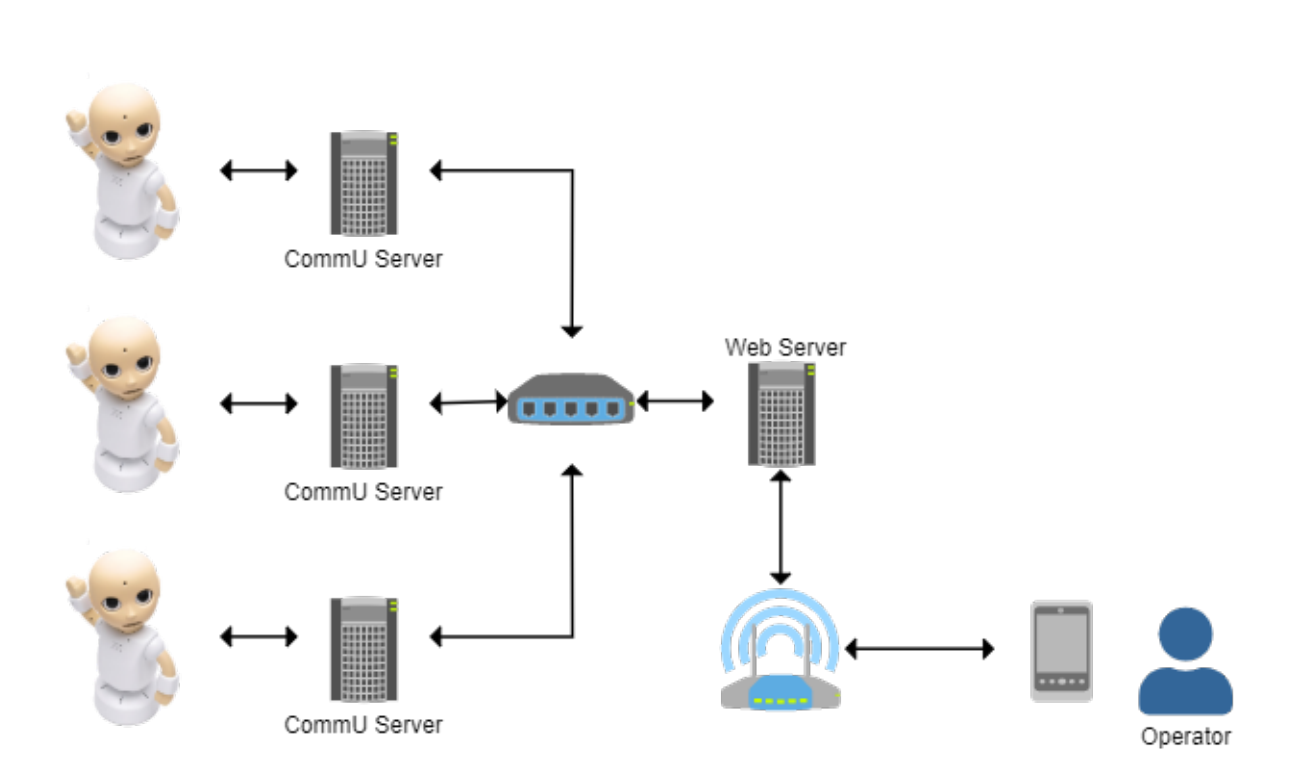
Figure 3. Network system configuration used for the field